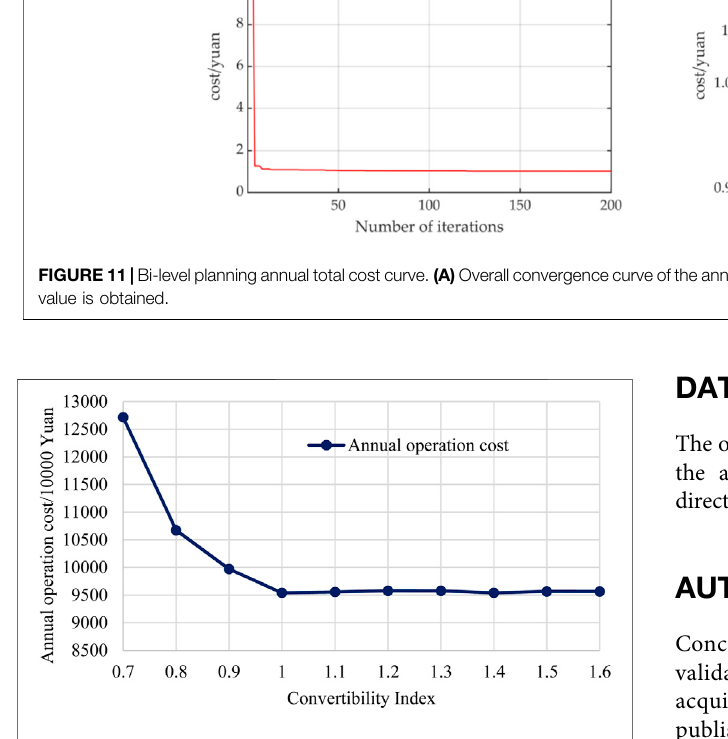
FIGURE 10 | Annual operation cost with different